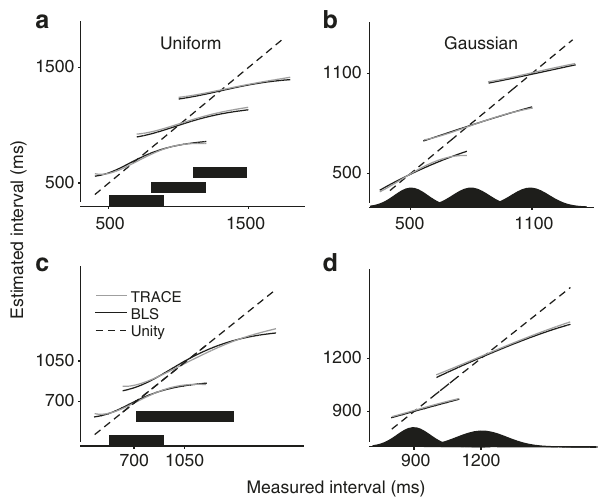
Fig. 3 Comparison of TRACE and BLS for different priors. a Estimates derived from Bayes-Least-Squares (BLS) (black line) and TRACE (gray line) for three different uniform prior distributions (solid black) with different means. b Same as a for three Gaussian prior distributions. c Same as a for two uniform priors with different means and widths. d Same as c for Gaussian priors. We used a linear scaling parameter to calibrate the output of TRACE and added the mean of the prior as an offset so that TRACE and BLS could be compared